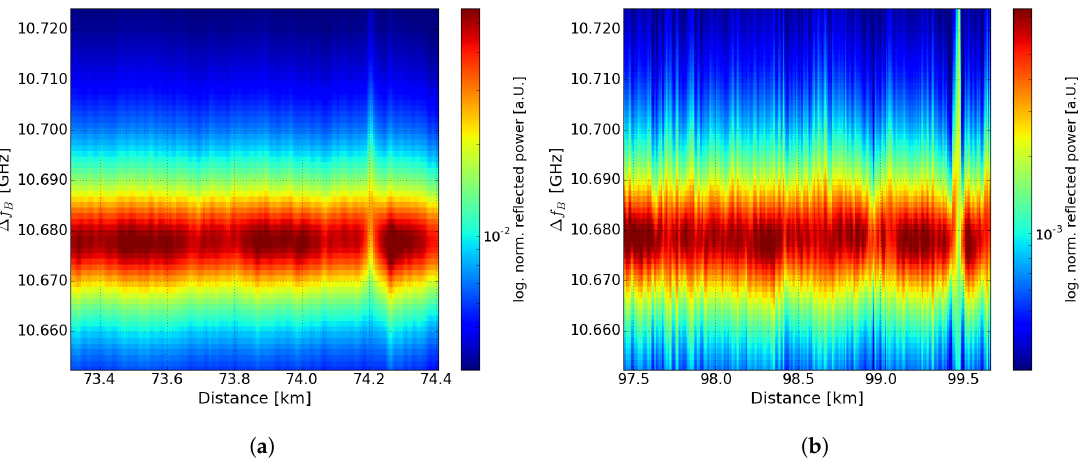
Figure 9. Color plot of logarithmized normalized reflected power of the Brillouin spectrum of a 40 m fiber section at ( a ) 74.2 km at a hotspot of 20 ◦ C and ( b ) 99.48 km at a hotspot of 30 ◦